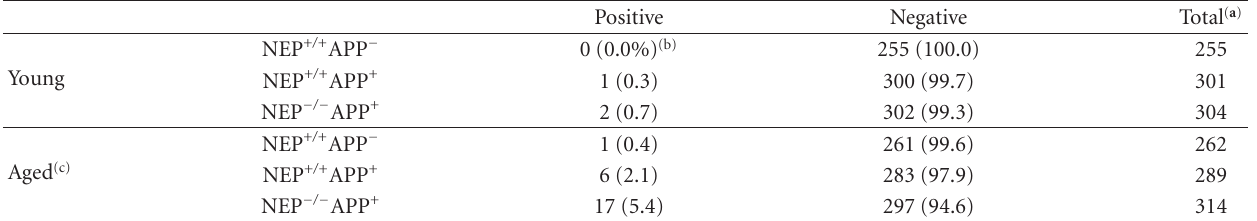
Figure 3: Ultrastructural localization of anti-A β N-terminal immunoreactions ( α A β N-terminal IRs) in aged NEP − / − APP + (a) and aged NEP + / + APP + (b) mouse brain sections. (a) α A β N-terminal IRs (arrow, representative) were strongly observed on amyloid fibrils in senile plaques. Ax: axon, Den: dendrite, and AT: axon terminal. (b) Intracellular α A β N-terminal IRs observed on Golgi apparatus (Go) and lysosomes (Ly) in neuron. Scale bar = 200 nm. Nu: nucleus, Mit: mitochondria. Table 2: The number and percentage of α APF-positive and -negative synapses.